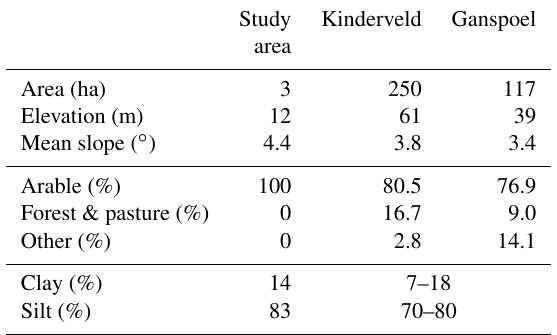
Table 2. Area, topographic characteristics, land use, and soil of the study area and the two evaluation catchments.